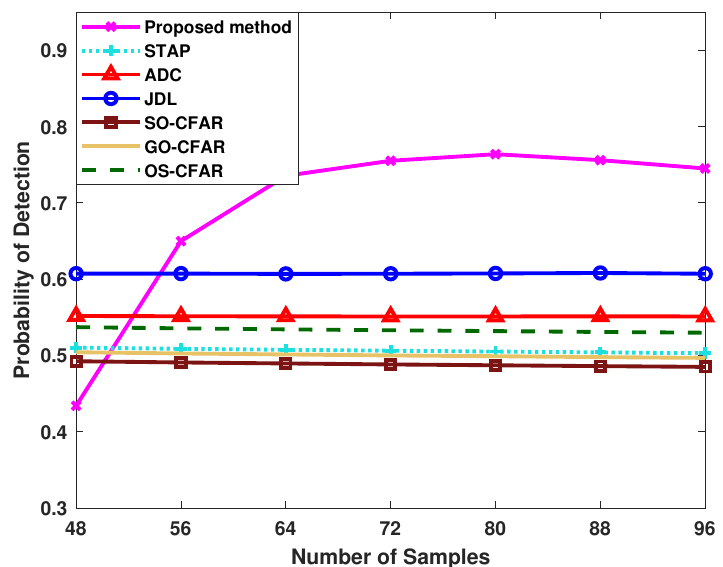
Figure 7. PD with variation in the number of training samples. The adaptation level of the proposed unsupervised algorithm for different ϑ of non- side-looking arrays is verified in Figure 8, where the non-side-looking angle described before Equation (1) is defined as ϑ = ( − 90 + ∆ θ p ) ◦ , and ∆ θ p changes from ∆ θ p = 0 ◦ to ∆ θ = 15 ◦ . In addition, SNR = − 10 dB, PFA = 5 × 10 − 4 and the others are the same as p those of Figure 1. For the proposed clustering algorithm, the changes of the radar system configurations cause different input data. Therefore, based on the original parameter settings, the parameters are adjusted to u d 1 = 8 − ∆ u , u d 2 = 10 − ∆ u , u d 3 = 11 − ∆ u , = 30 − ∆ u and u = 42 − ∆ u , where ∆ u = ceil { ( ∆ θ + 1 ) /5 } − 1, with ceil {·} being u d p d 5 4 an integer that is not less than {·} . From Figure 8, we can analyze that with the variations in ϑ , there are fluctuations in detection performance. For further improvement of the detection of the proposed method, more precise parameter settings can be introduced. However, on the whole, in Figure 8, the proposed unsupervised algorithm still performs far better than the others.